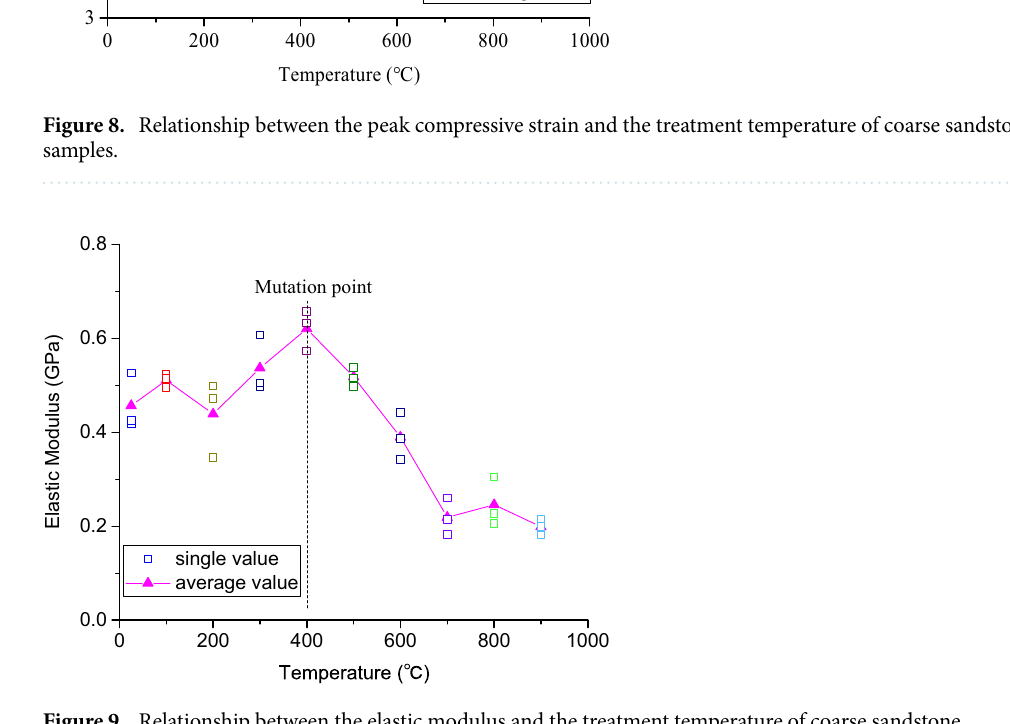
Figure 9. Relationship between the elastic modulus and the treatment temperature of coarse sandstone